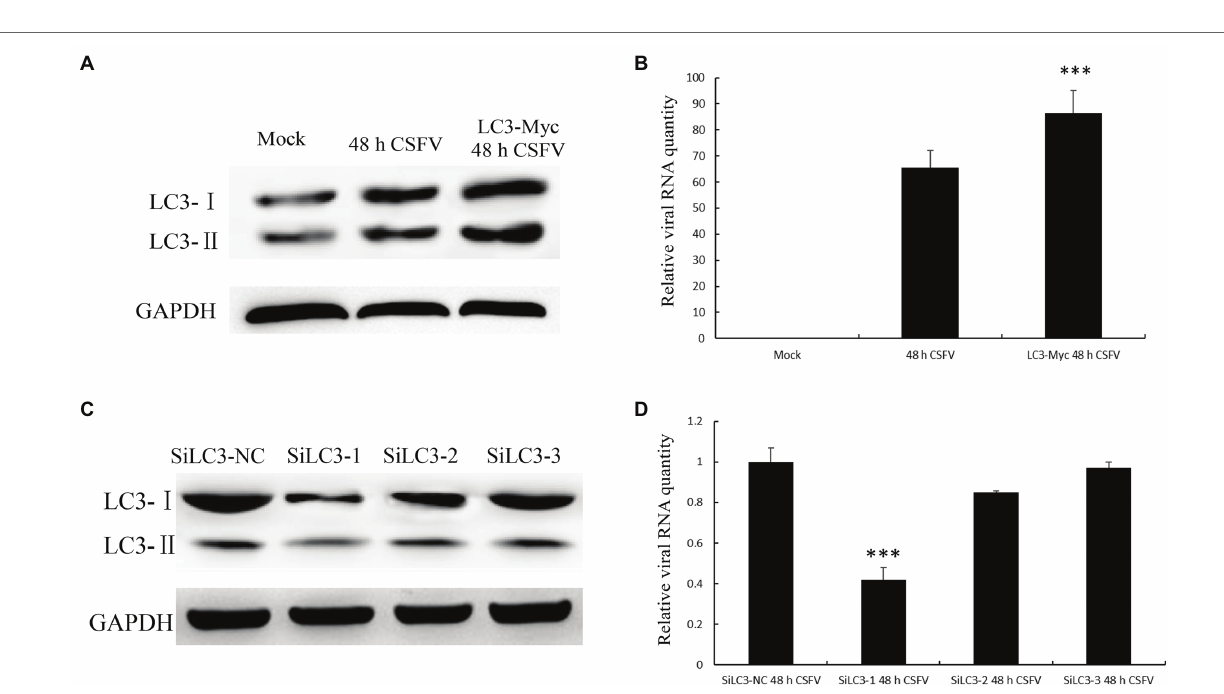
FIGURE 8 | Light chain 3 promotes CSFV propagation. (A) LC3 overexpression and CSFV infection showed changes in the protein level of LC3. (B) The change in CSFV RNA expression level when LC3 was overexpressed. (C) Knockdown of LC3, mediated by small interfering RNA (siRNA), showed changes in LC3 expression levels. (D) The change in CSFV RNA expression level when LC3 expression was knocked down. The data represent the mean ± SD of three independent experiments. Statistical comparisons were evaluated using ANOVA followed by Tukey’s HSD post hoc analysis. *** p < 0.001 compared with the mock